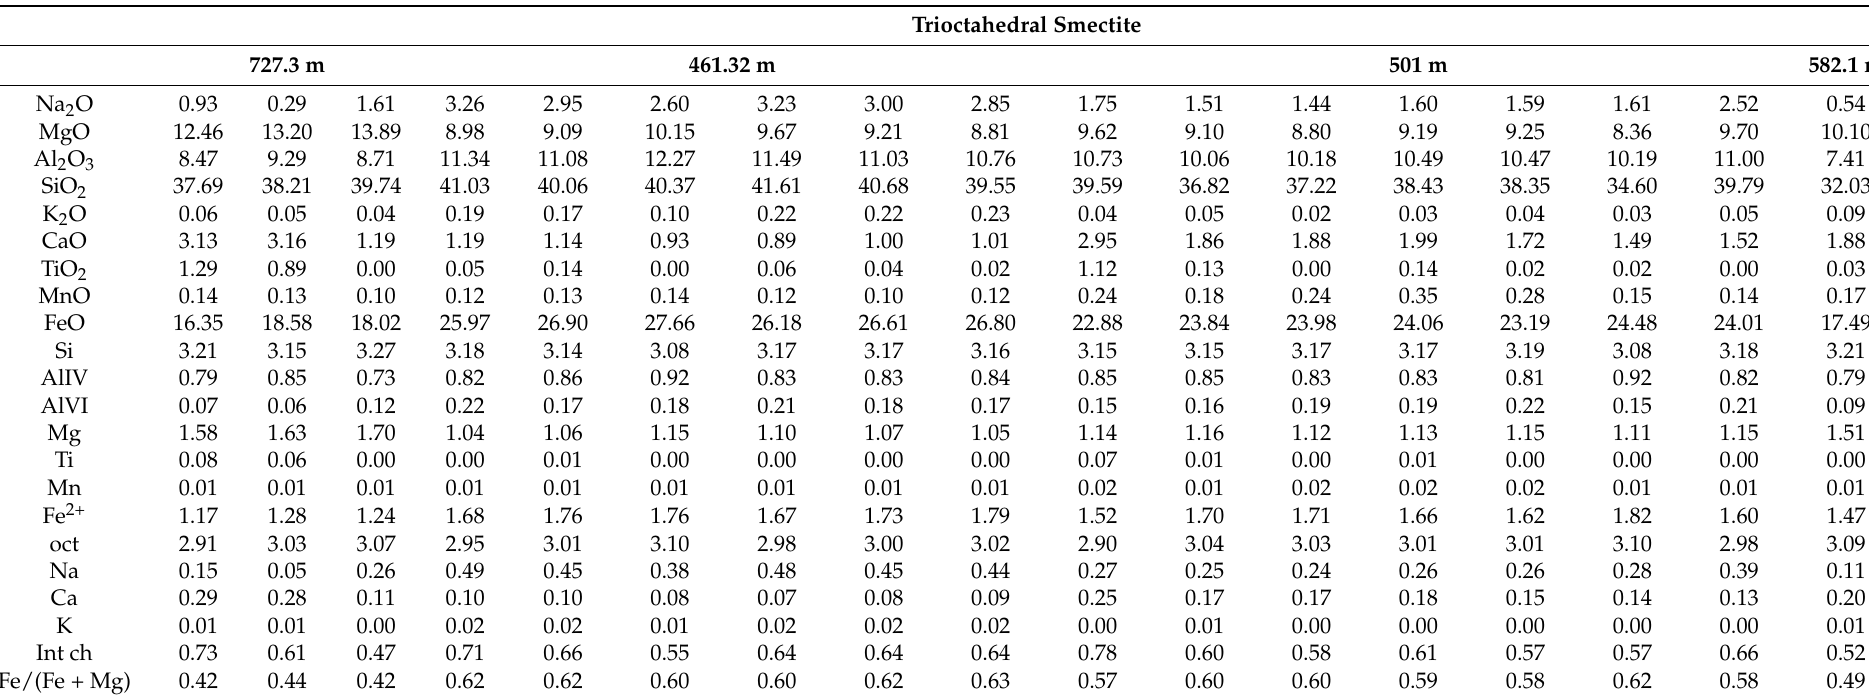
Table 3. Representative chemical compositions of trioctahedral smectite. Structural formulas are calculated per half formula unit (11 oxygens). Analyses obtained by EDS on polished thin